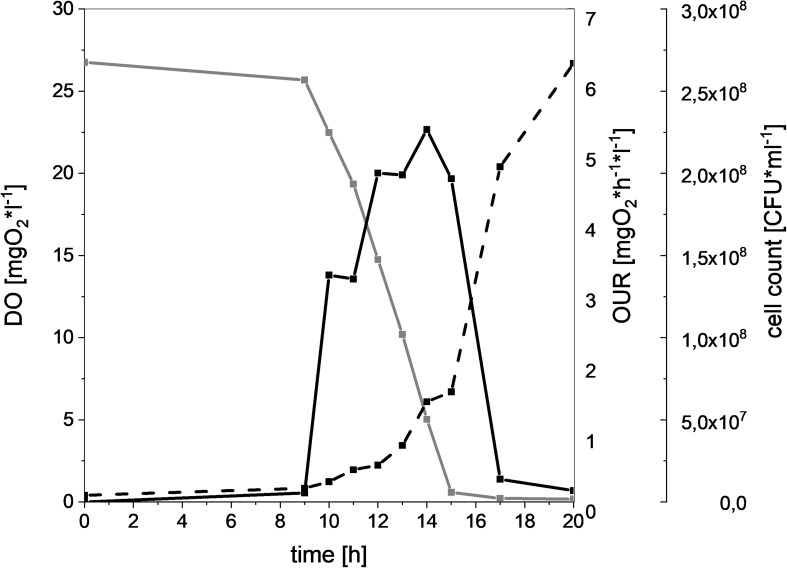
Oxygen consumption and cell growth of L. gelidum subsp. gelidum under high oxygen atmosphere. Dissolved oxygen [mgO2∗l–1] (gray solid line), oxygen uptake rate [mgO2∗h–1*l–1] (black solid line), and cell count [CFU∗ml–1] (black dotted line) of L. gelidum subsp. gelidum TMW2.1618 replicate 1.